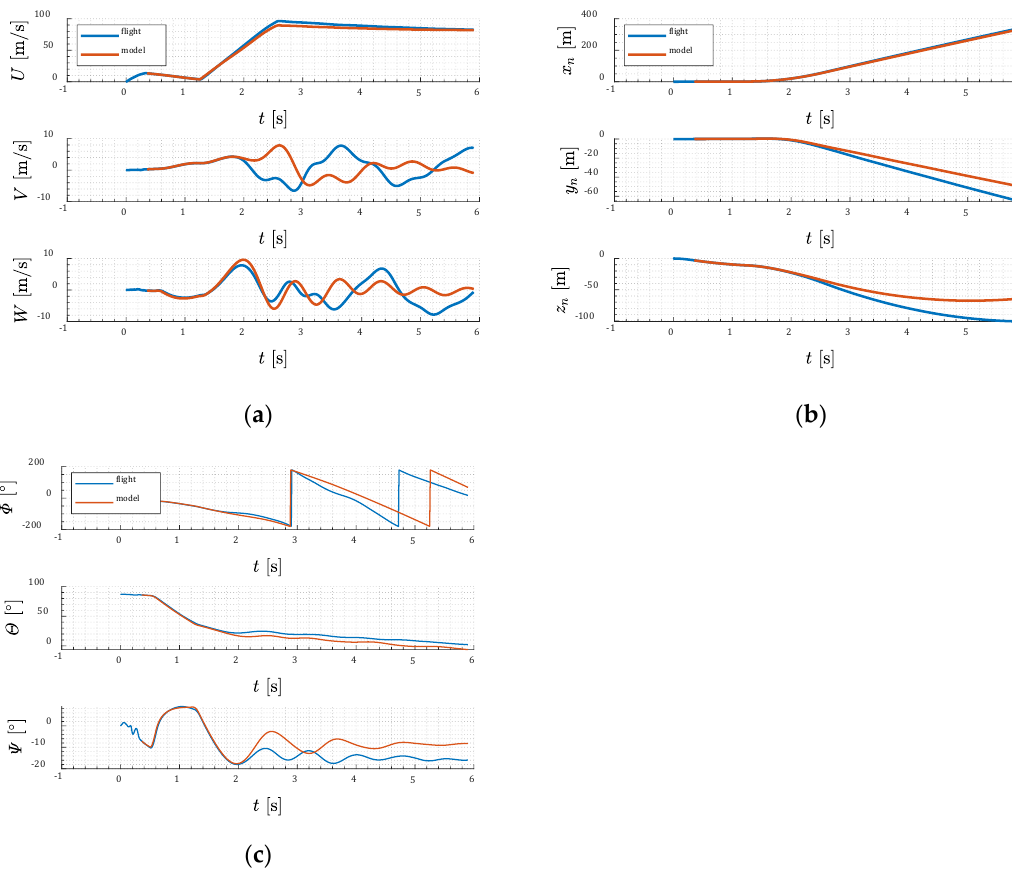
Figure 31. ( a ) Projectile velocity; ( b ) projectile position (test 3, lateral thrusters before the center of mass); ( c ) Euler angles.